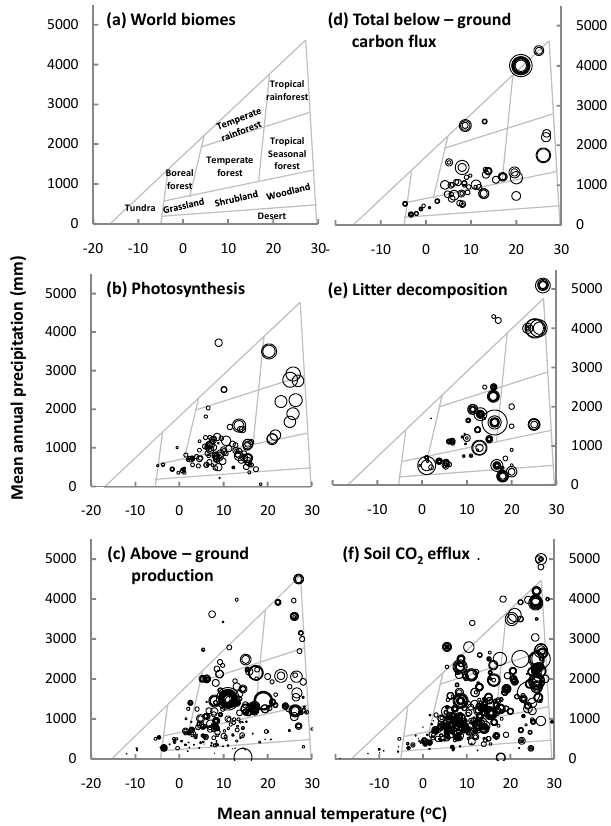
Figure 3) Distribution of plant biomes 1 (a) , annual gross primary productivity 2 (b) , annual aboveground plant productivity 3 (c) , total annual belowground carbon flux 4 (d) , litter decomposition rate 5 (e) and soil CO2 efflux 6 (f) in relation to mean annual site air temperature and rainfall. Note that a number of factors (e.g., vegetation and/or soil type) co-vary with global temperature and moisture gradients. Belowground carbon flux is presented only for forest ecosystems, the other variables span all ecosystems for which data are available. Soil CO 2 efflux data is presented only for unmodified, natural systems. The diameter of the circles denotes the magnitude of the values. Data sources: 1 Whittaker (1975); 2 Luyssaert et al. (2007); 3 Ohnson et al. (2001); 4 Litton and Giardina (2008); 5 Zhang et al. (2008); 6 Bond-Lamberty